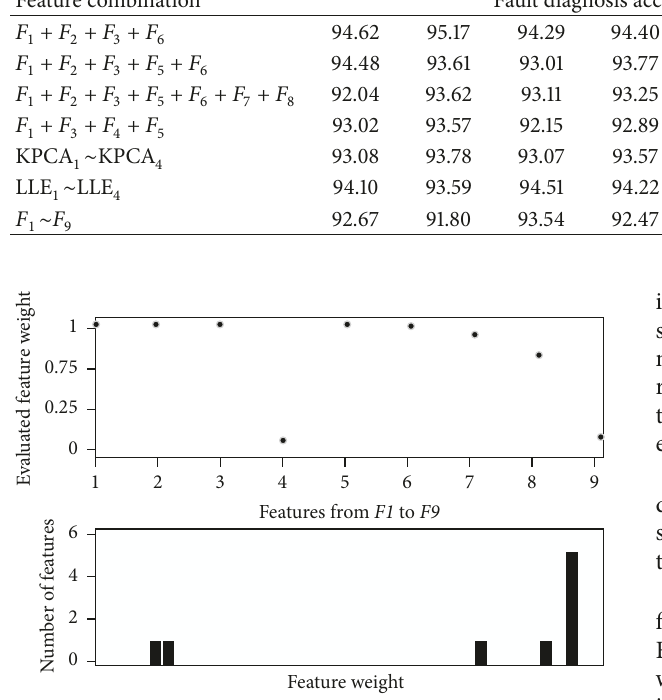
Table 5: Fault diagnosis results with different combinations of features. Feature combination Fault diagnosis accuracy of the 10-fold cross validation method (%)